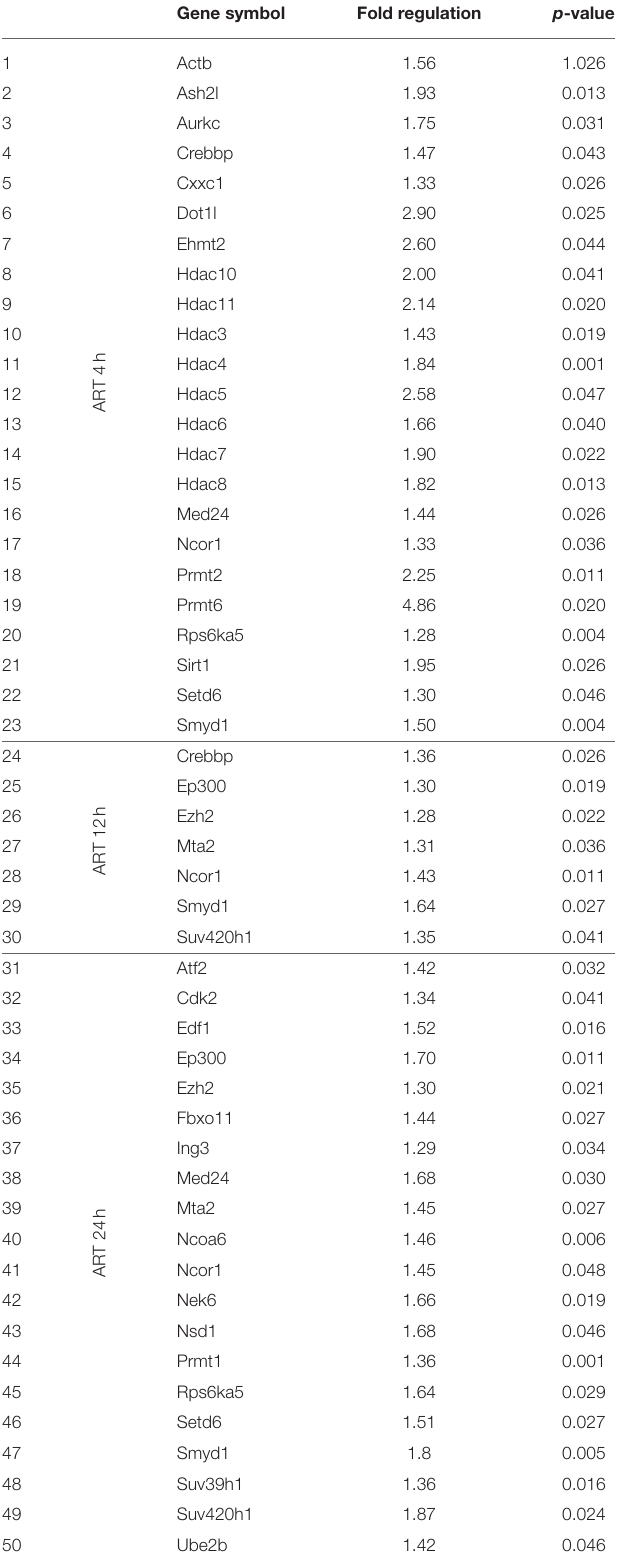
TABLE 2 | PCR array analysis of differentially expressed epigenetic chromatin modifying enzymes on ARV drugs treatment. Gene symbol Fold